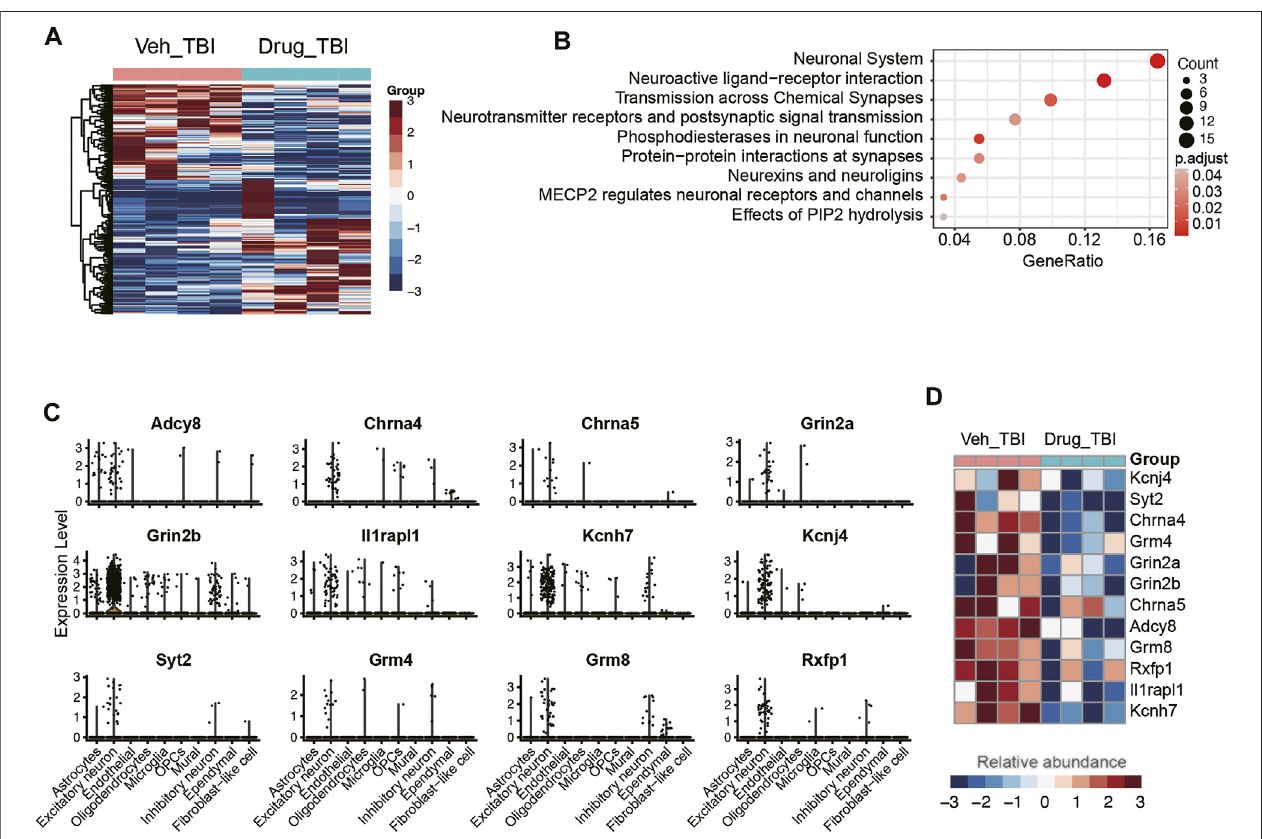
FIGURE 7 | The association of excitatory neurons with angiotensin treatment. (A) The differentially expressed genes between the angiotensin-treated (Drug_TBI) and untreated (Veh_TBI) samples. (B) The pathways enriched by the downregulated genes of angiotensin-treated samples. The genes speci fi cally expressed in excitatory neurons (C) were downregulated in angiotensin-treated samples (D) .